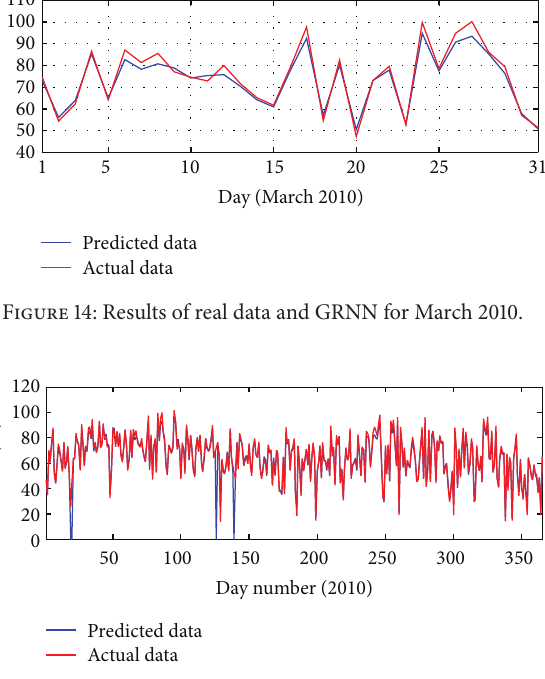
Figure 15: Overall results for real data and GRNN for 2010. GRNN network has only one free parameter as spread which is the distance of an input from a neuron’s weight [40]. Different spread values have been examined to find the best